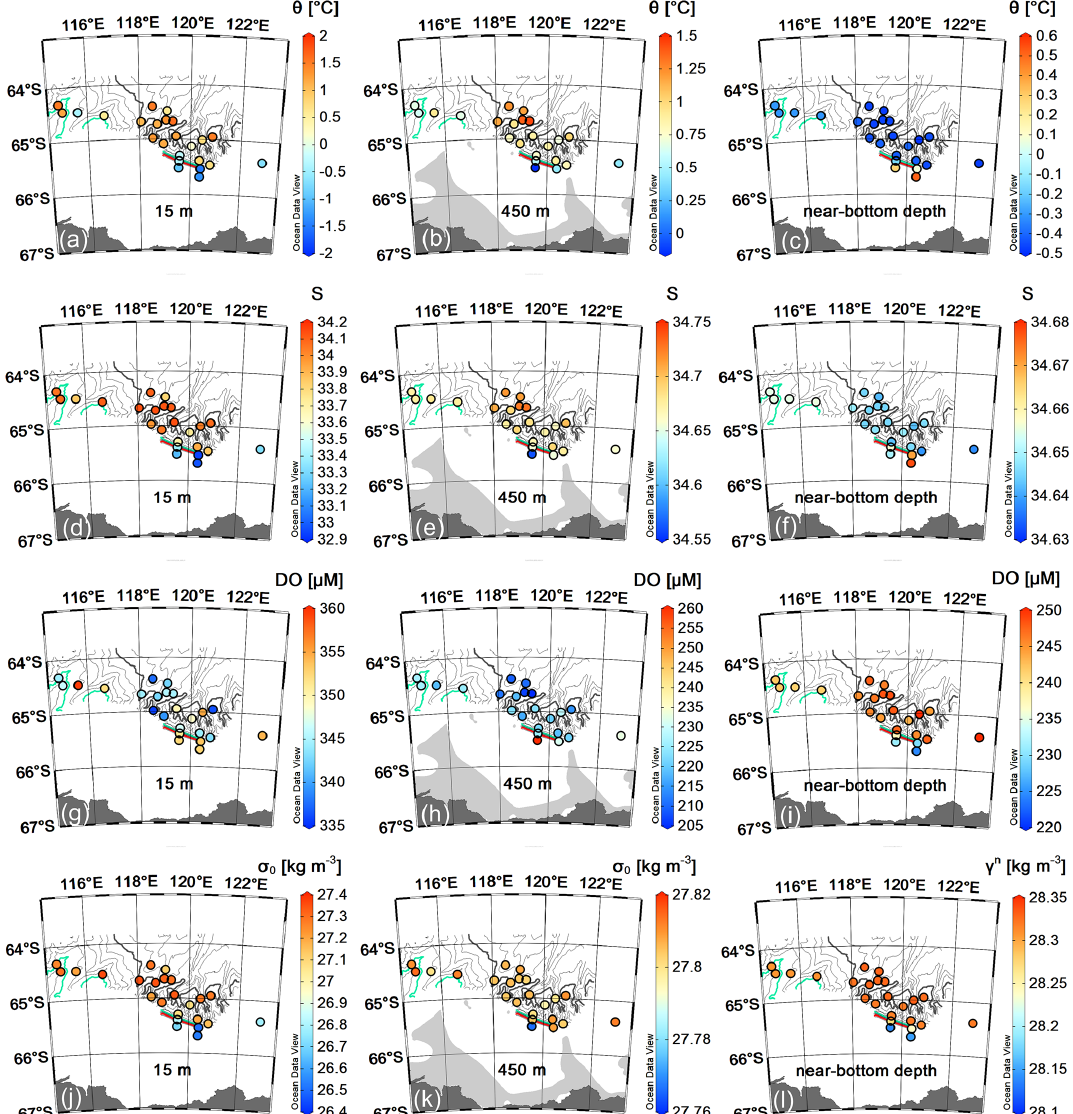
Figure 9. Near-surface (15m depth), intermediate (450m) and near-bottom θ (a–c) , S (d–f) , DO content (g–i ), σ θ (j, k) and neutral density γ n (l) . The background bathymetry consists of isobaths (thin black curves) every 200m obtained from multibeam data acquired during the 2017 campaign; thick lines indicate isobaths at 1000 (red), 2000 (cyan), and 3000m (grey).